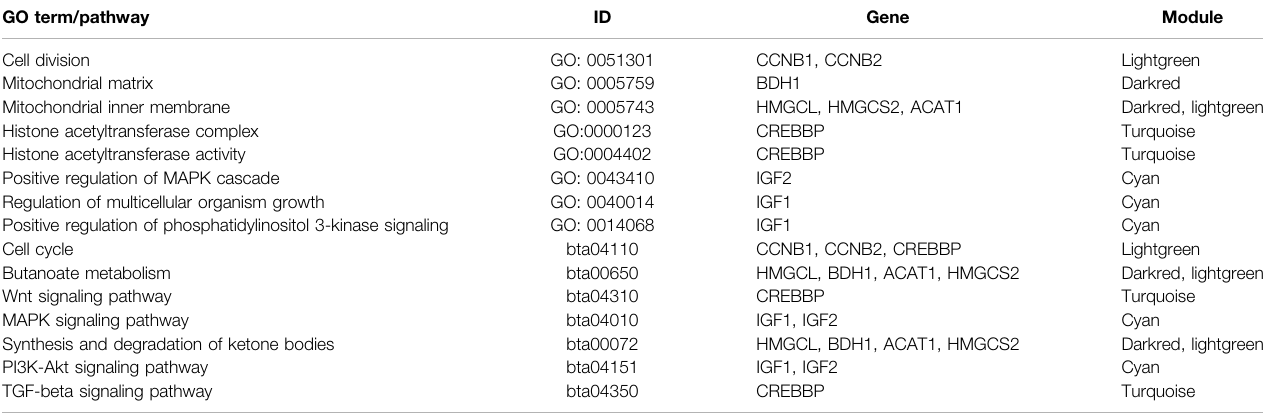
TABLE 3 | Various GO terms and pathways related to rumen development shown from different modules. GO term/pathway